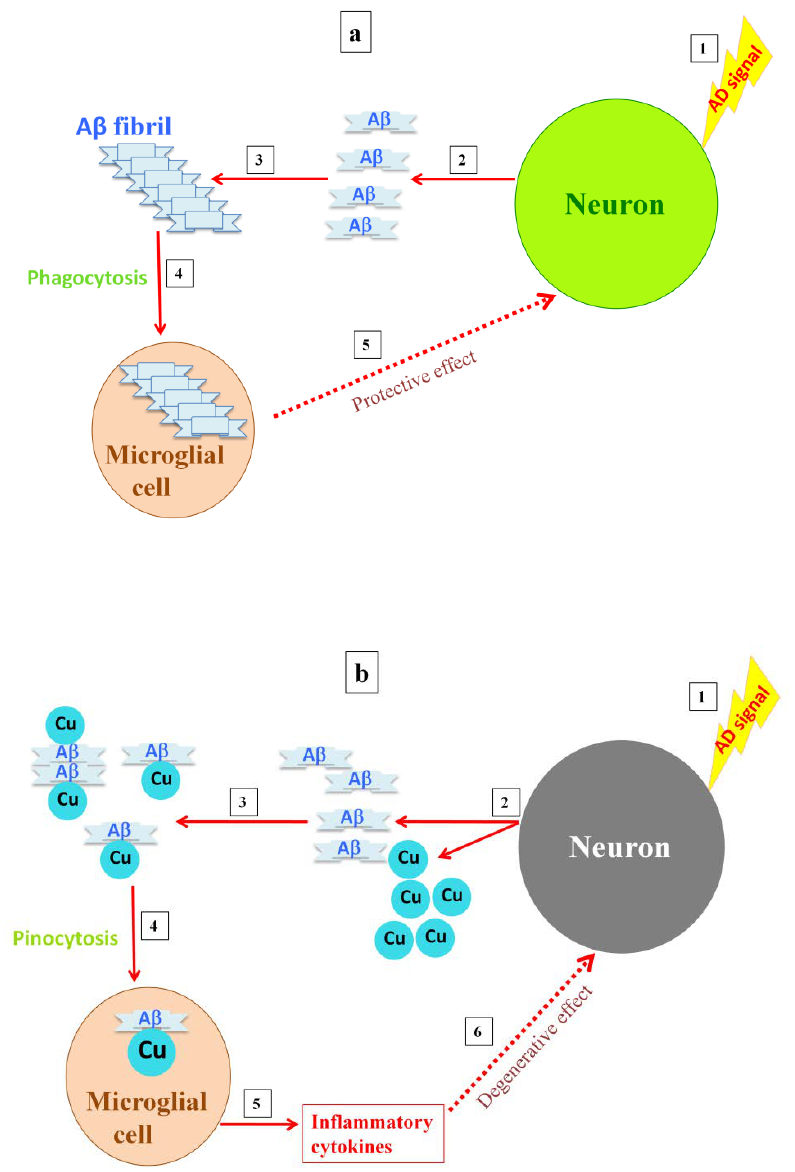
Figure 1. Postulated differences in microglia activity with either the absence or presence of a high copper concentration. When high levels of amyloid are released into the synapse, amyloid fibrils are formed and the microglia are activated, clearing the fibrils by phagocytosis ( a ). Releasing high levels of copper into the synapse, as copper inhibits the NMDA receptor, results in soluble A β deposits, which are then taken up by microglia via pinocytosis, causing overactivation of the microglia and inflammation ( b